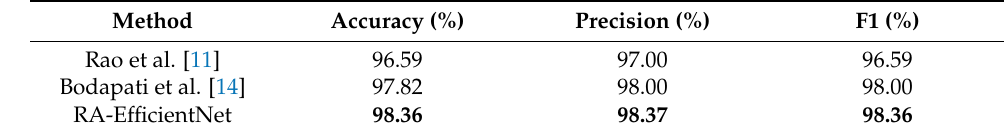
Table 5. Comparison with existing works for task 1 on APTOS 2019 dataset.